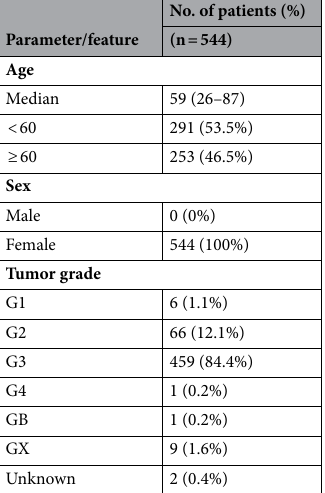
Table 1. Clinical parameters of ovarian cancer patients from the TCGA.